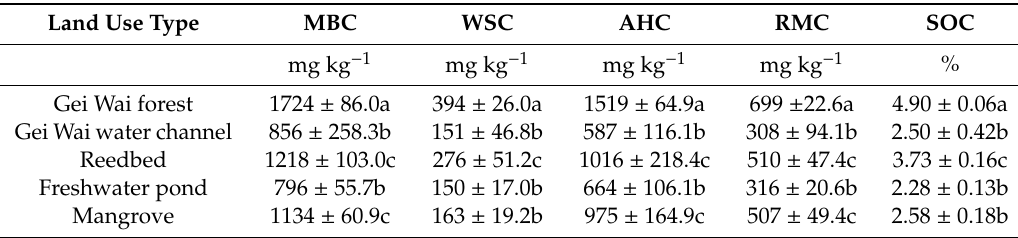
Table 2. Concentrations of various soil C fractions in the top 10 cm soils for the five land use types (means ± standard deviation, n = 3).